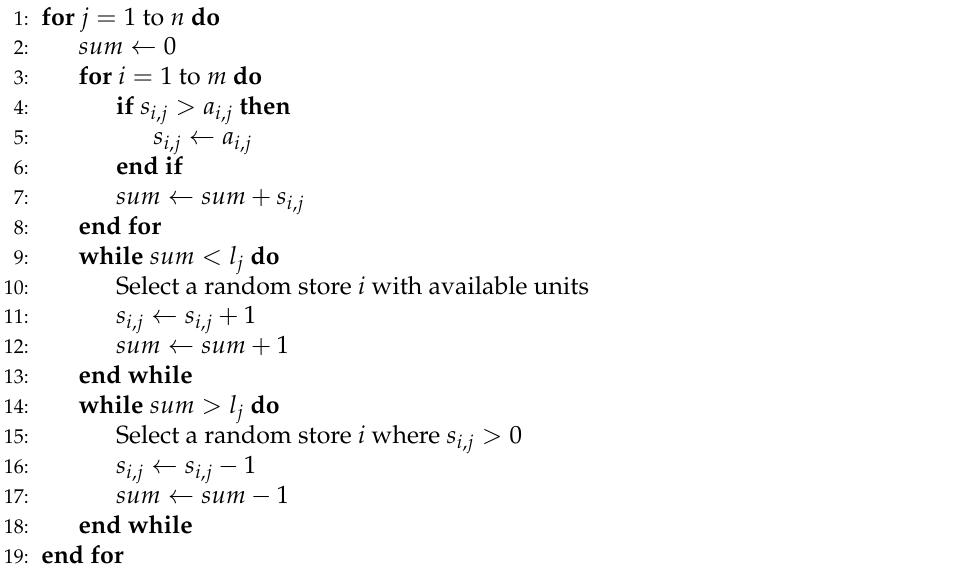
Algorithm 4 Proposed solution repair for the ISHOP with item units.